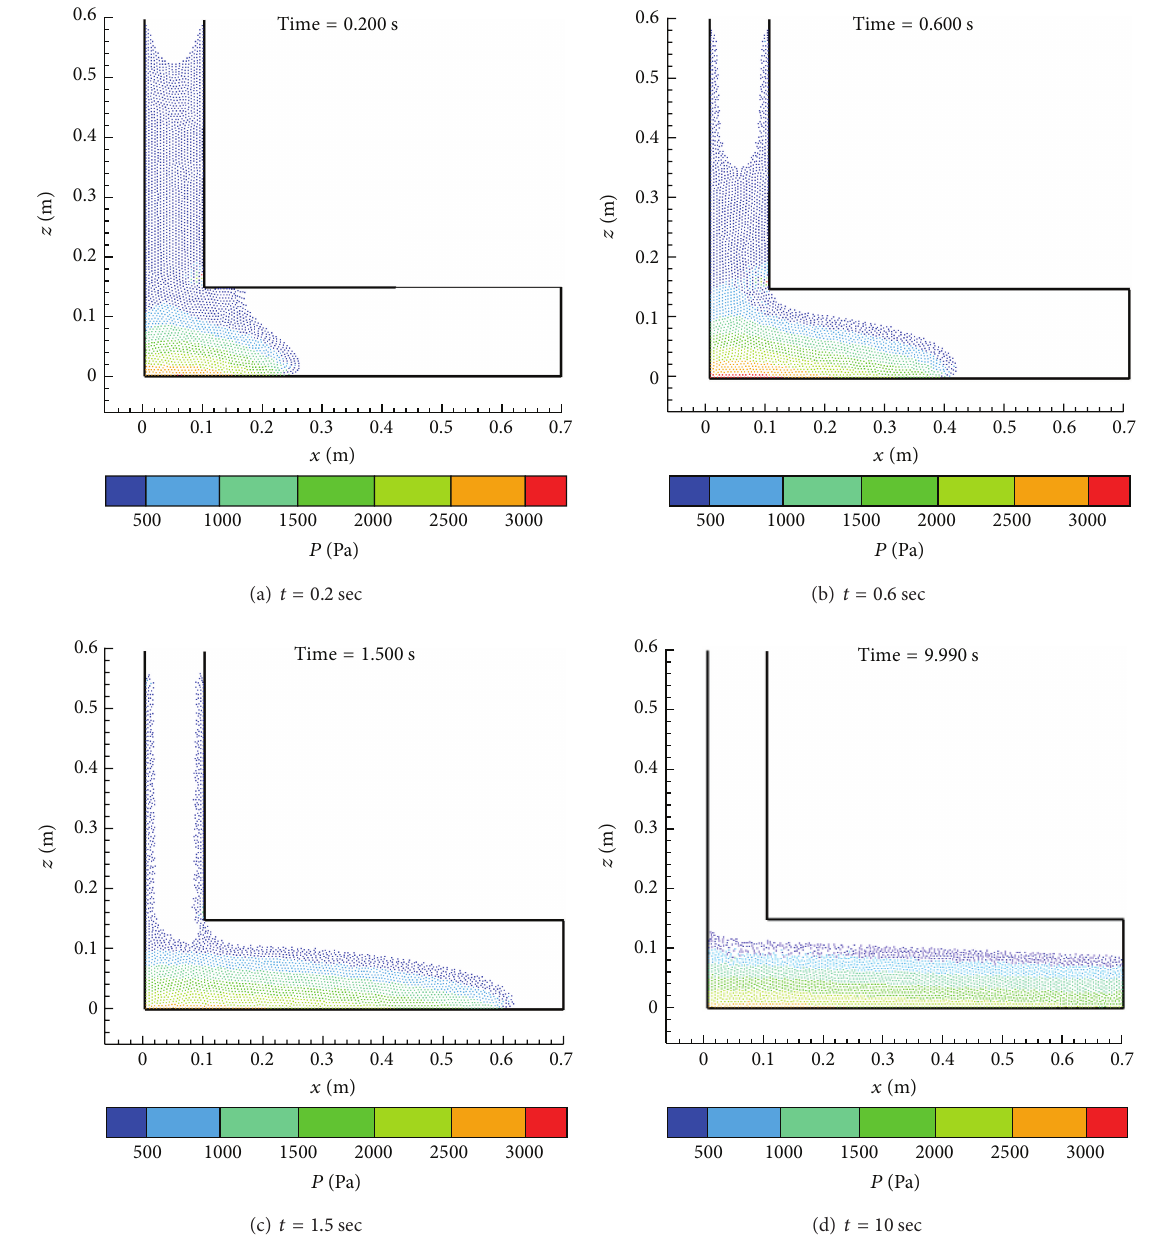
Figure 7: Simulation of L-box testing for SCC with pressure